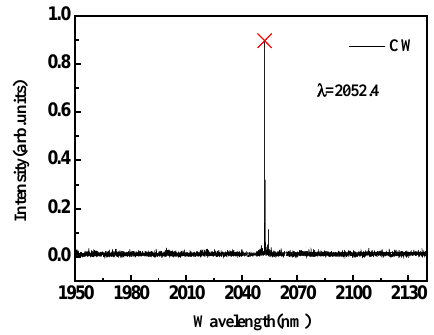
Figure 9. Laser spectral in continuous wave (CW) mode. Appl. Sci. 2016 , 6 , 128